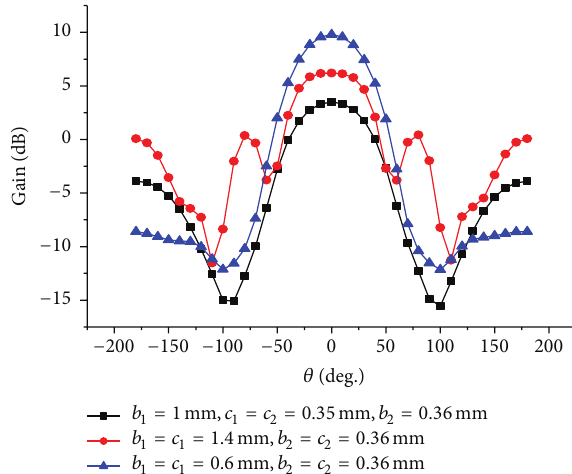
Figure 8: The gain of the 100GHz rectangular antennas ( ℎ = 1.3𝜆